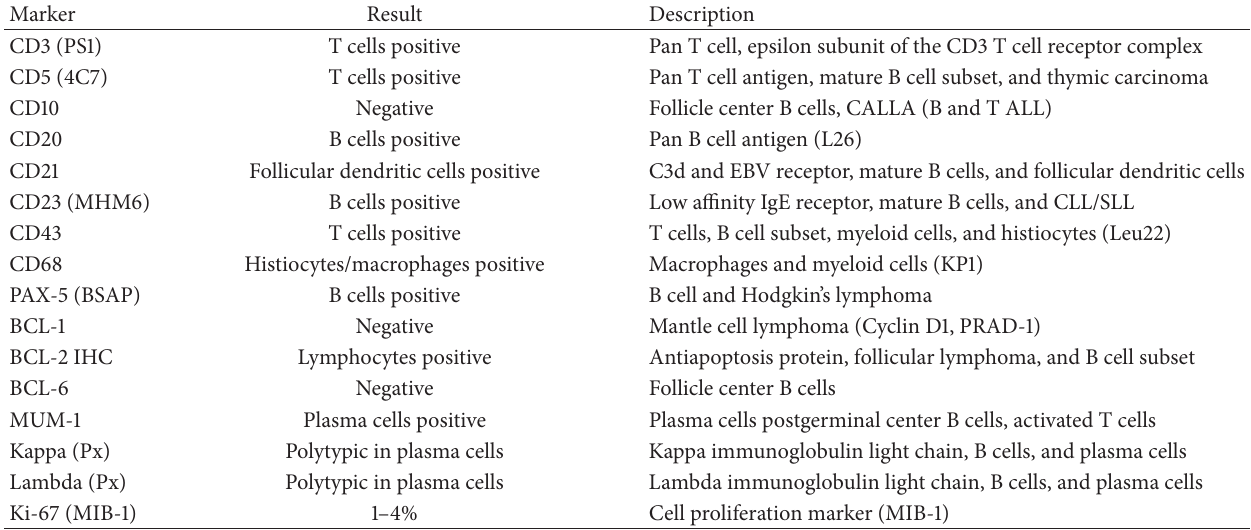
Table 1: Immunohistochemistry